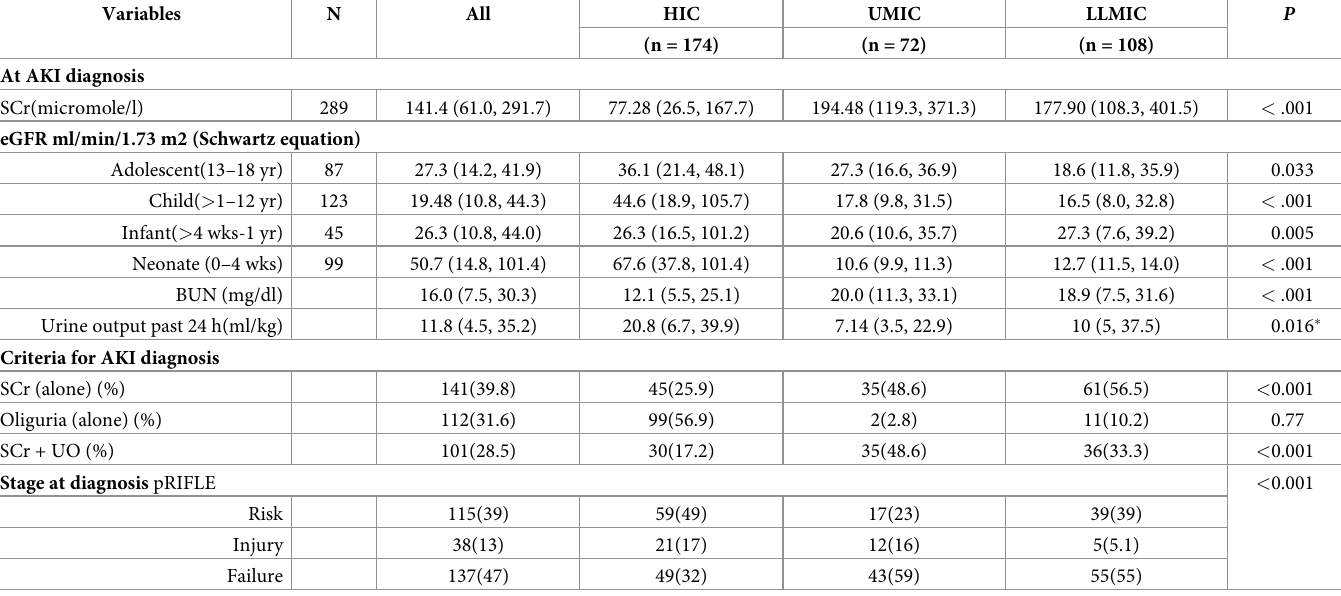
Table 2. Renal functions by GNI country